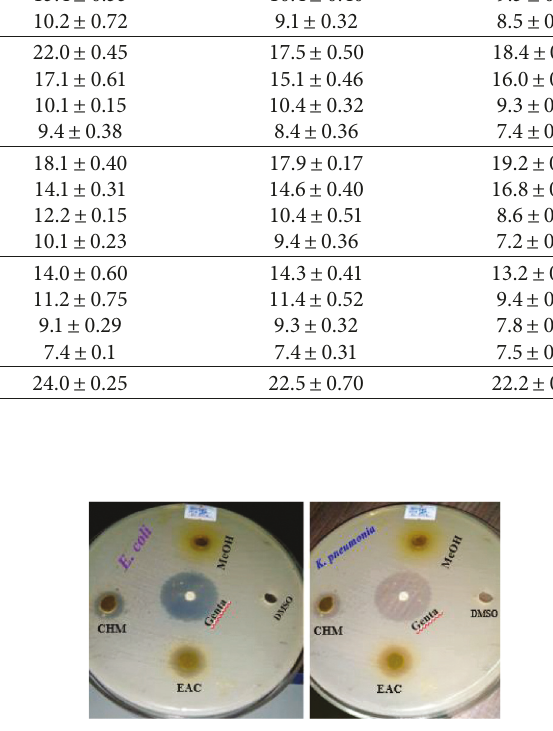
Figure 2: Zone of inhibition of E . coli and K . pneumonia by extracts at